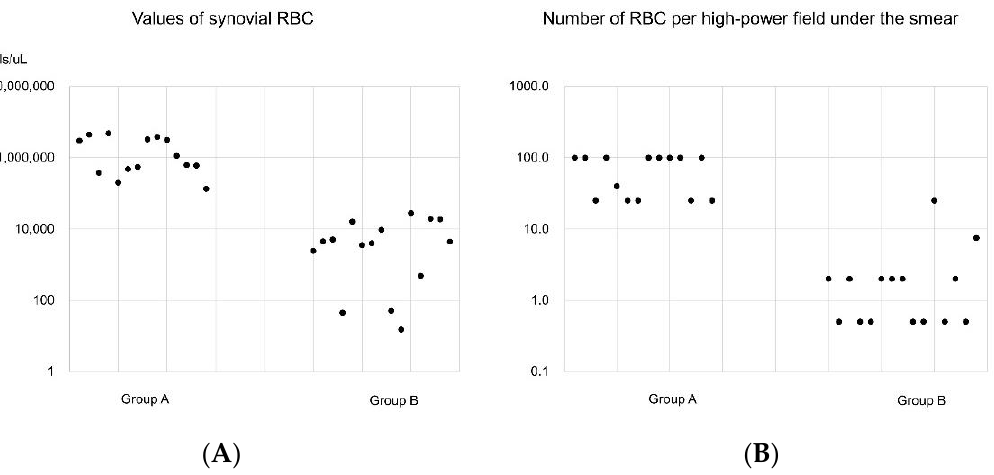
Figure 2. ( A ) Values of synovial red blood cells (RBCs) and ( B ) number of RBCs per high-power field under the smear of the synovial fluid smear. Group A: interventional angiography and selective embolization after failed conservative treatment. Group B: successful results after conservative treatment.